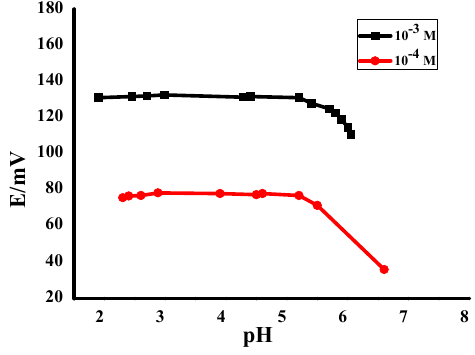
Figure 8. The e ff ect of pH on the potentiometric response of the applied sensor. Figure 8. The effect of pH on the potentiometric response of the applied sensor. Table 2. The selectivity coe ffi cients (log K pot FLX, J ) of the proposed sensor. Interfering